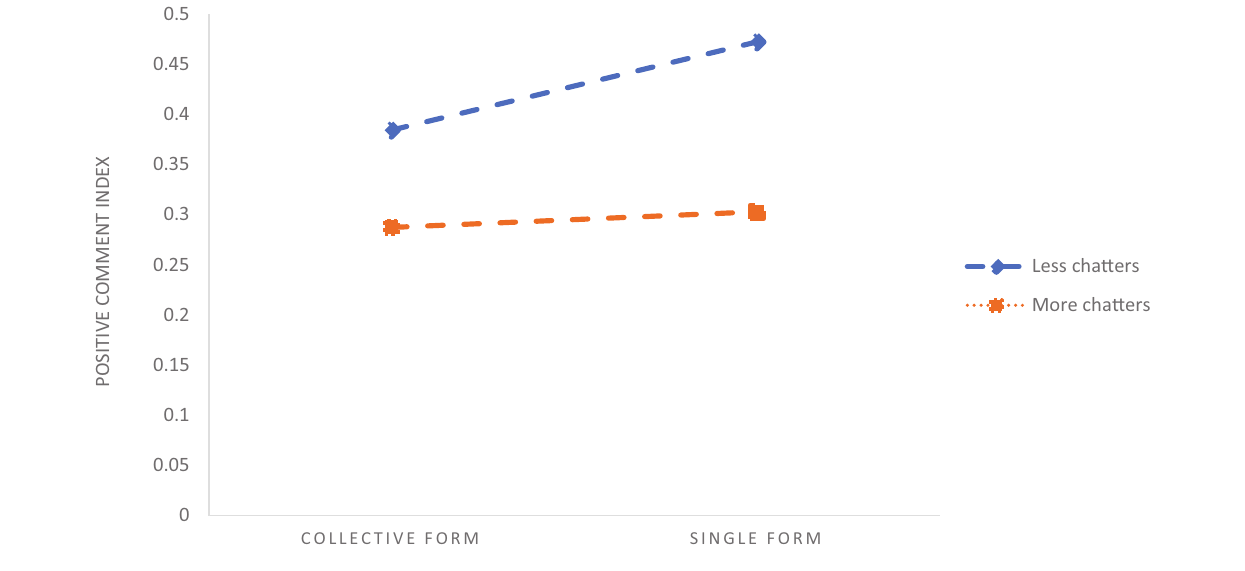
FIGURE 5 | Chatter’s role in moderating the form of anti-rumour.